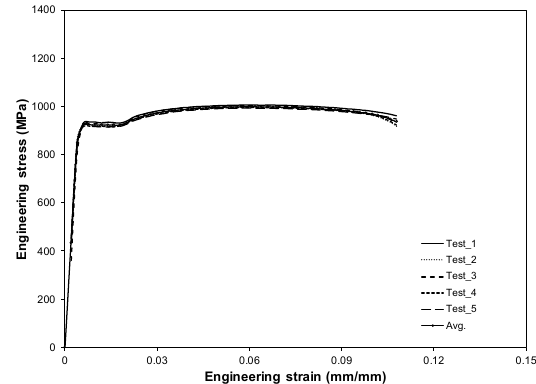
Fig. 7. Experimental engineering stress strain for Material 2 at 1 s -1